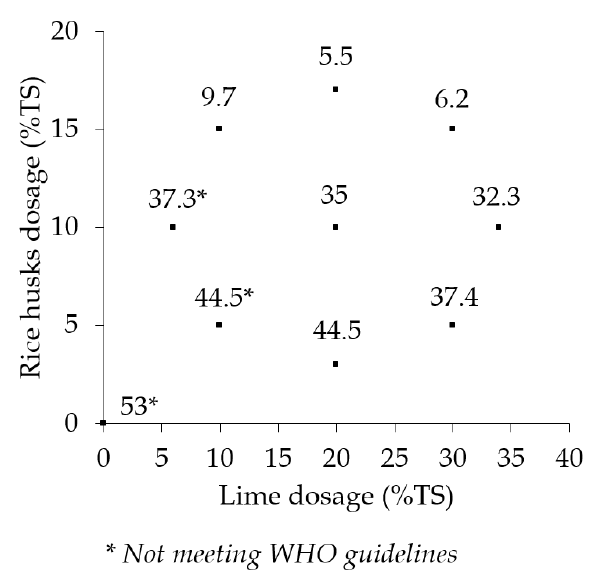
Figure 2. Sludge dewatering cycle time (in days) for the treatments and the control. WHO: World Health Organization.